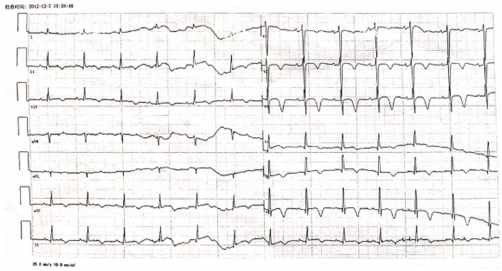
Figure 1: ECG upon arrival at hospital.